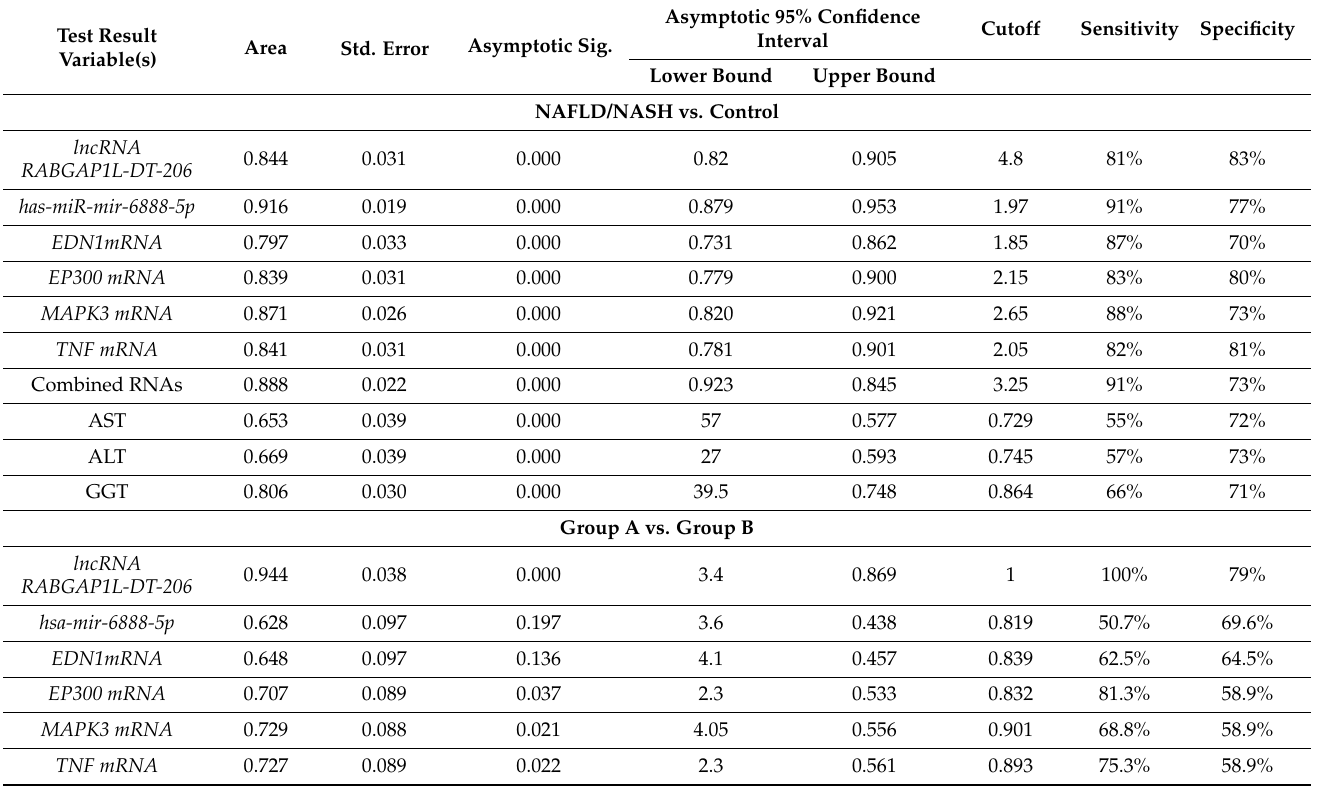
Table 2. Diagnostic performance of the molecular parameters among the study